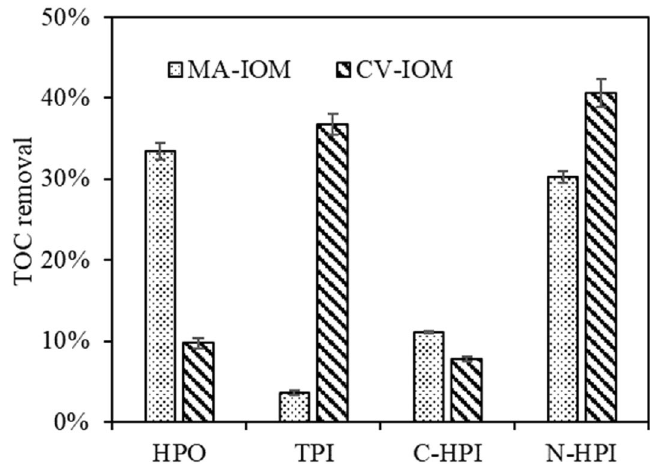
Figure 6. Organic removal of various CV-IOM and MA-IOM fractions.